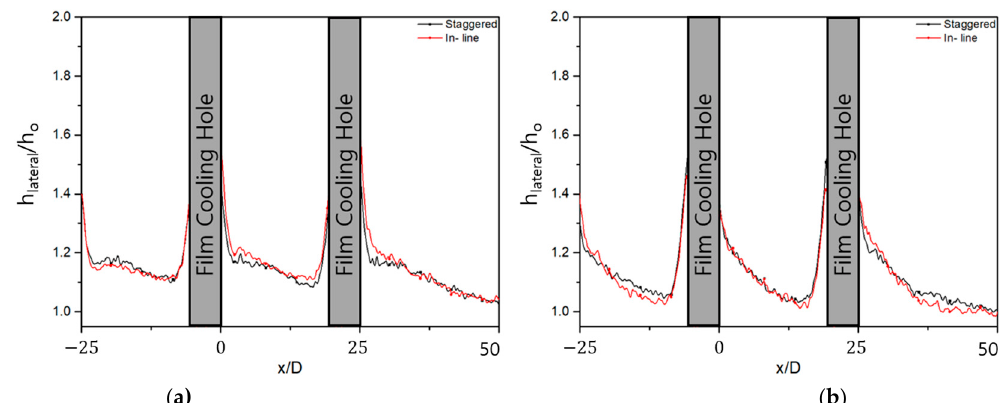
Figure 14. h lateral /h o for staggered and inline hole arrangements: ( a ) M = 1.0; and ( b ) M = 2.0.